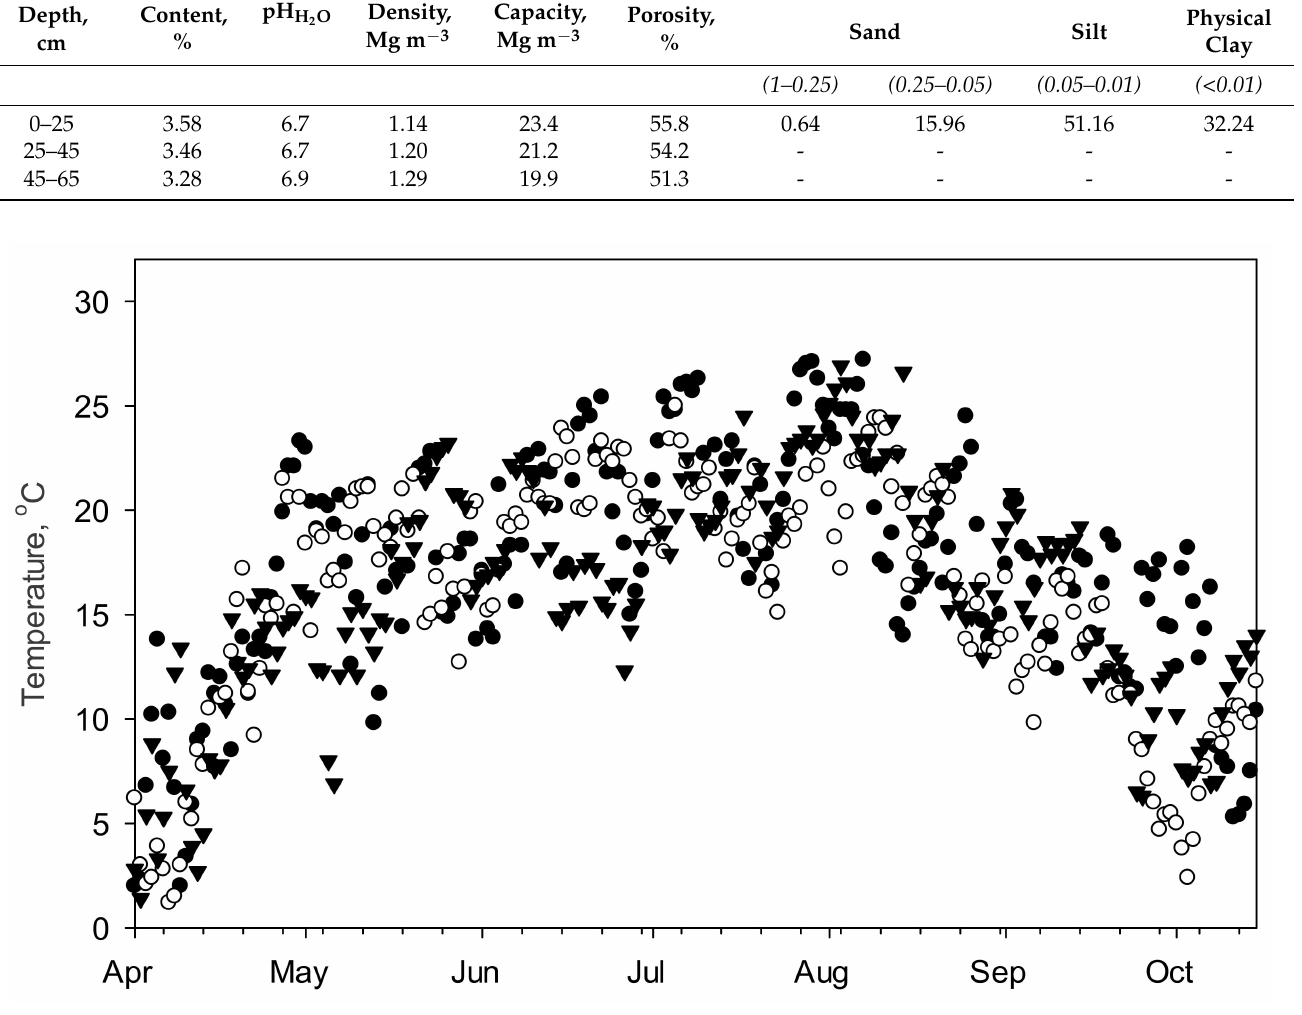
Figure 2. Temperature conditions from April to October 2012–2014 at the Velykosnyatynky research